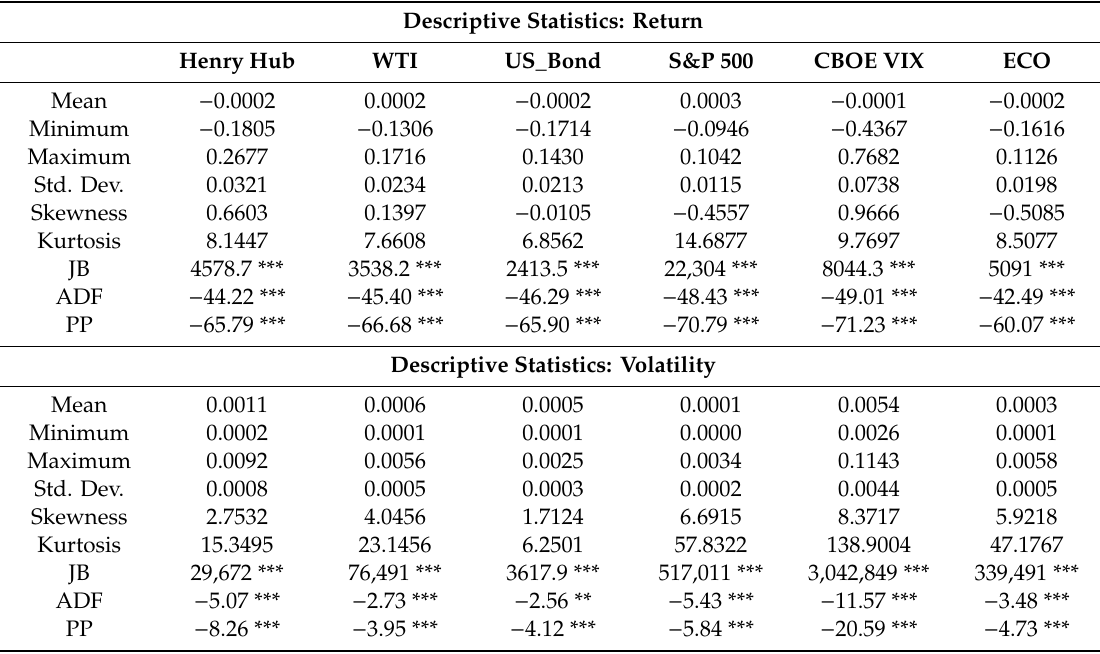
Table 2. Descriptive statistics: return and volatility series in the US.